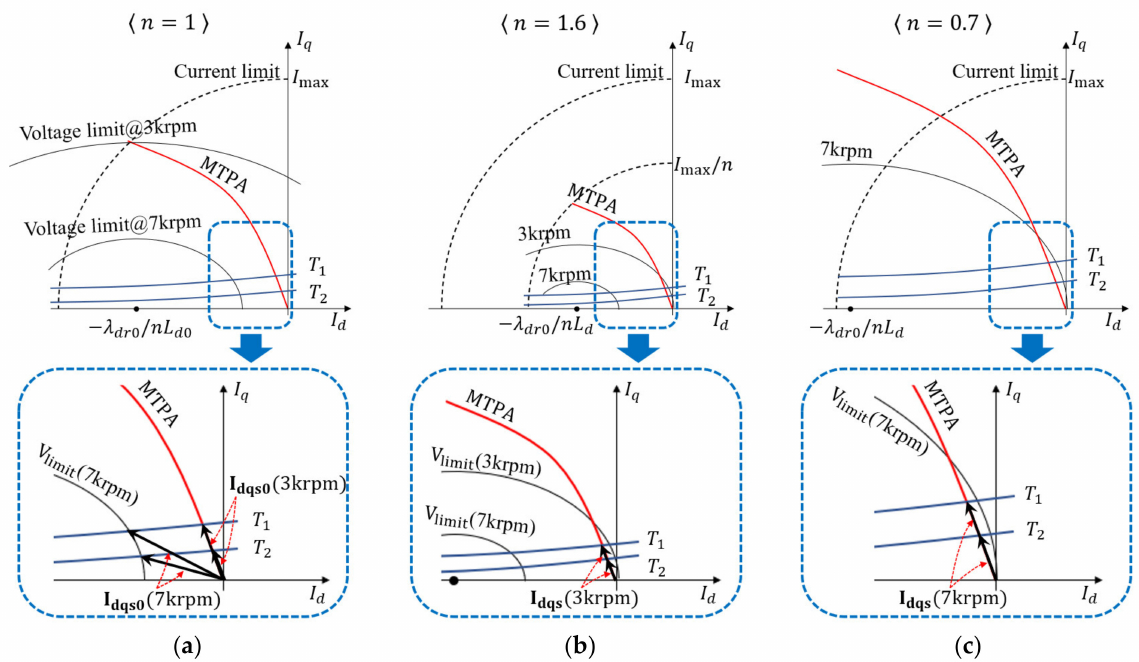
Figure 5. Comparison of the voltage limit and current vector at 3 krpm and 7 krpm with ( a ) n = 1, ( b ) n = 1.6, and ( c ) n =